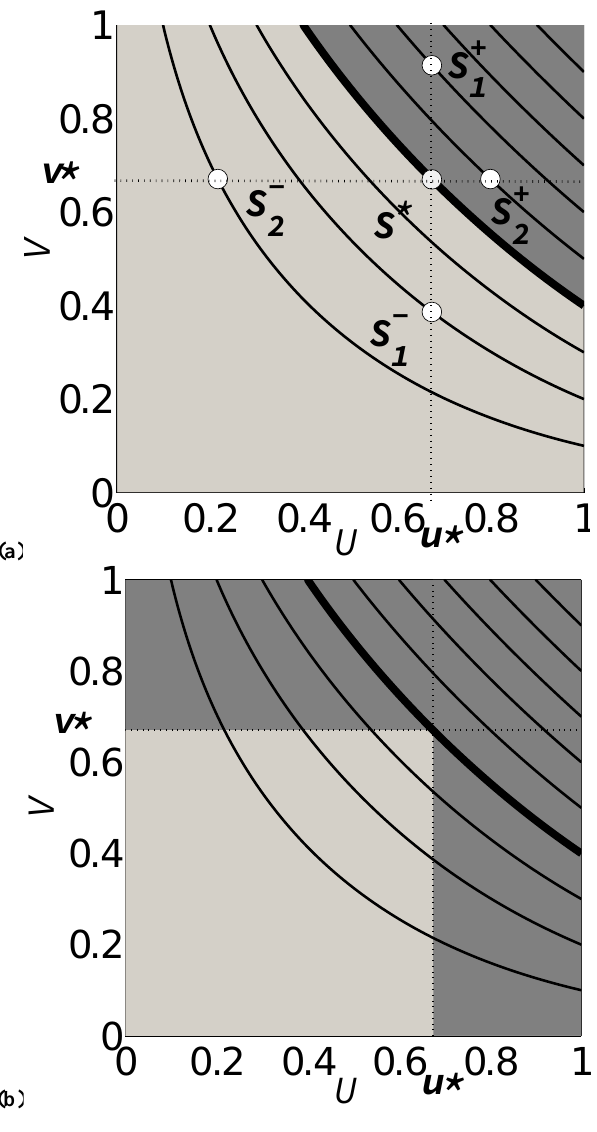
Fig. 1. Illustration of sub-, super- and critical storms (a) . Difference in probability used for secondary and primary return periods (dark gray area (a) vs. (b) ). (After Salvadori et al., 2007).